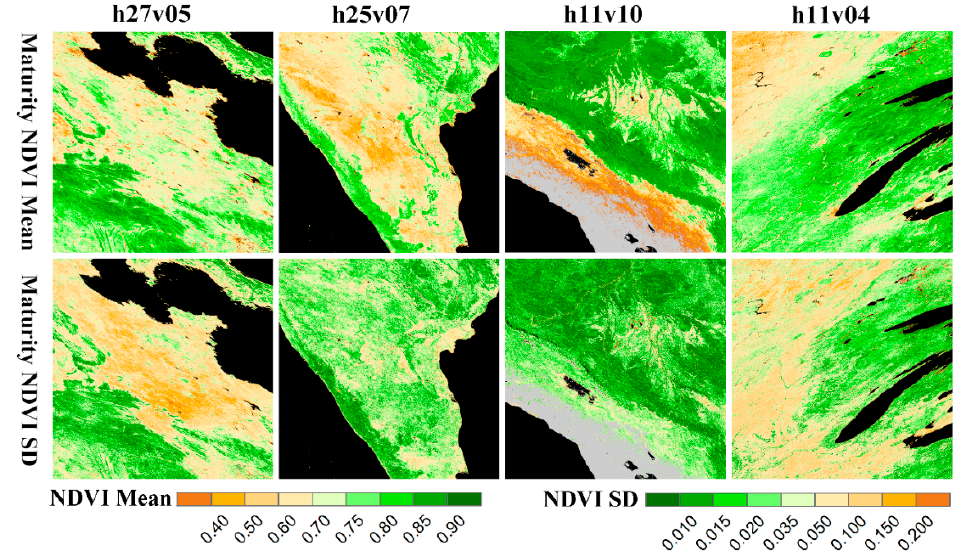
Figure 4. Maps of NDVI Maturity _ Mean and NDVI Maturity _ SD for four MODIS tiles in 2010, including h27v05, h25v07, h11v10 and h11v04. The gray color refers to non-vegetated areas.